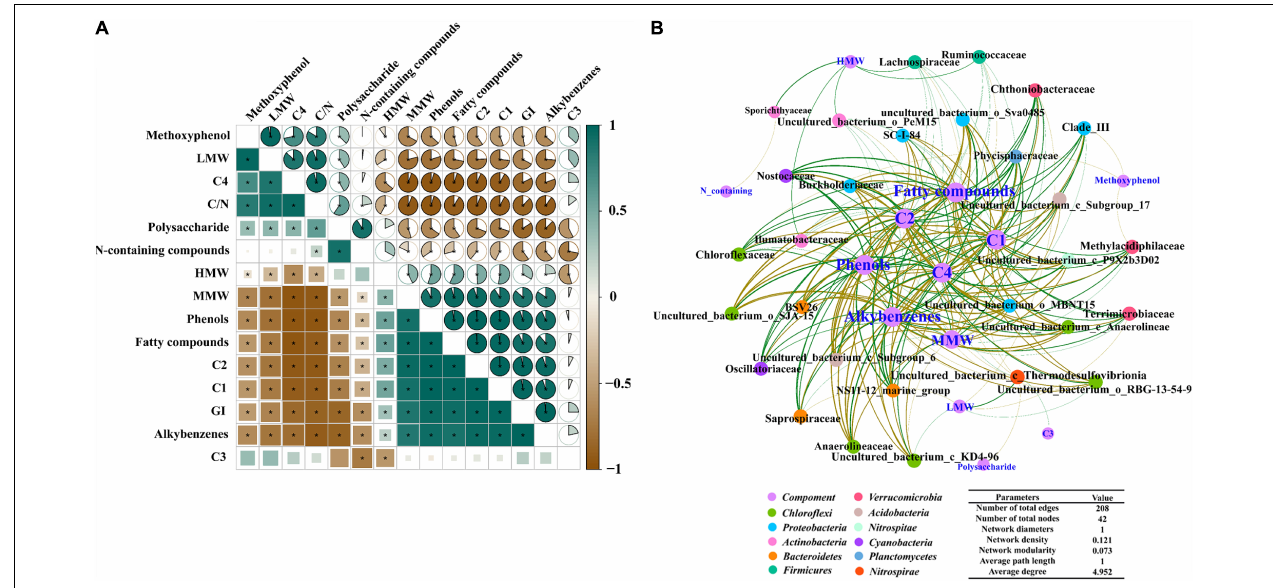
FIGURE 6 | (A) The correlation between substances transformation and maturity of ectopic fermentation systems (EFS; * ρ -value > 0.8, P < 0.05); (B) Molecular ecological network analysis of cooccurring bacterial community and molecular composition in